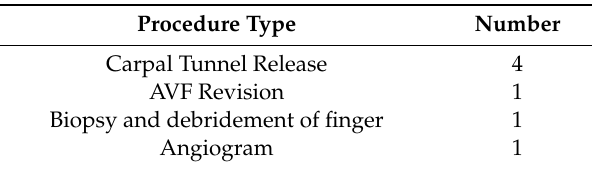
Table 1. Procedure